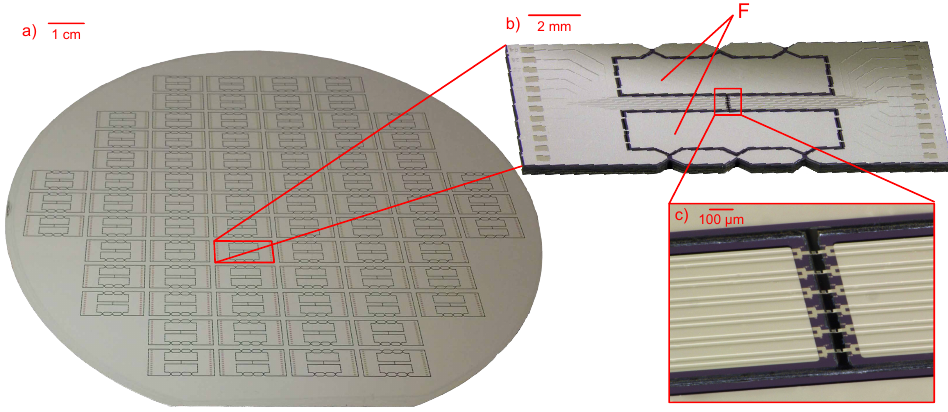
Figure 4. ( a ) A photograph of a completely processed wafer containing a number of test chips, held in the wafer frame by means of PI tabs; ( b ) A single test chip taken out of the wafer frame. The silicon areas next to the beams, denoted by F, are sacrificial and are removed before mounting; ( c ) A magnified image of the test structures that are freely suspended between the beams of the test